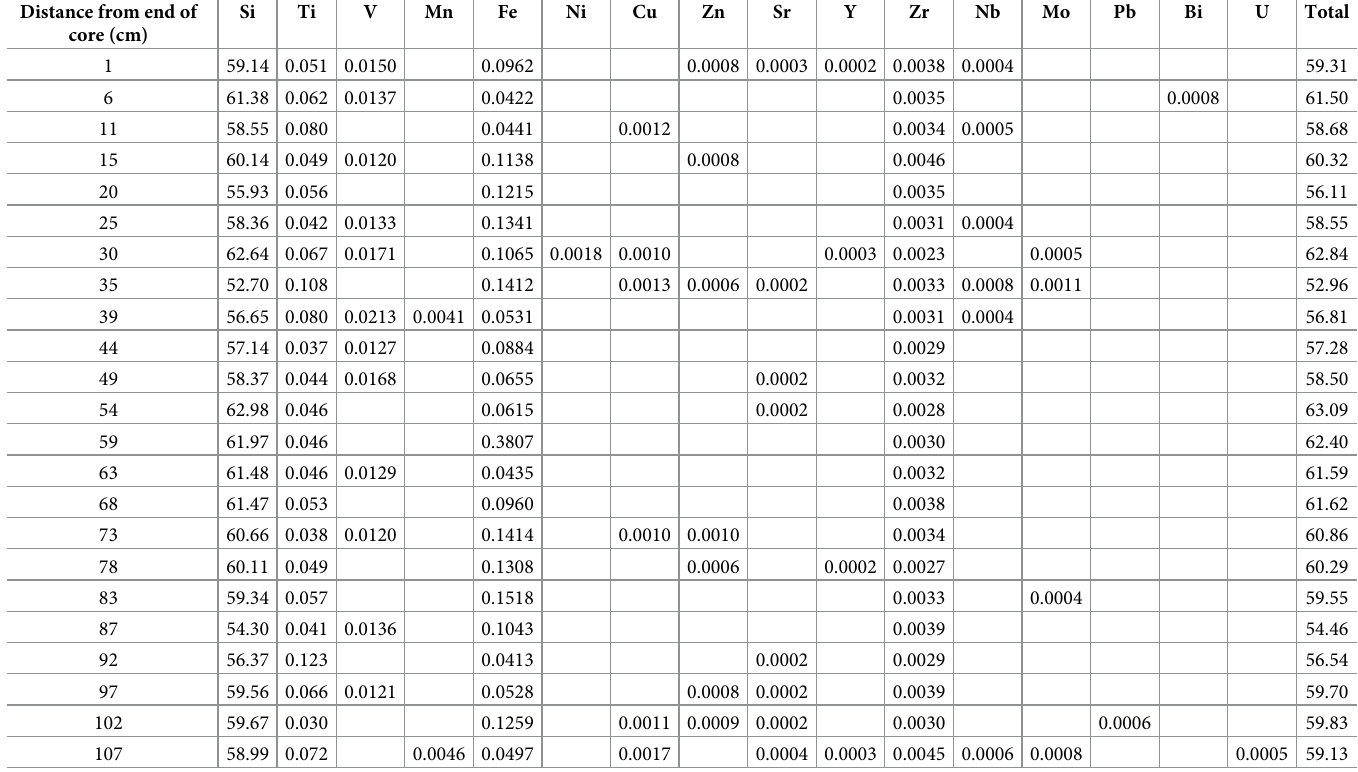
Table 4. Uncalibrated pXRF data showing element concentration (count %) measured at distances along the Phillips’ Core where elements were detected (blank cells = not detected). See Fig 5 for locations of analyses. Distance from end of core